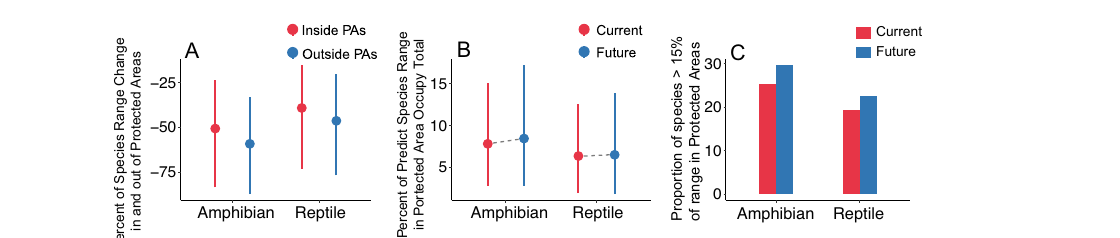
Fig. 2 | Climate change impacts on the percentage of species range (area of habitat) inside and outside PAs by 2070 (RCP 4.5). A Percent of species range change inside and outside PAs ( n =5399 and 8932 for amphibians and reptiles, respectively); B Percent of predicted species range in PAs at present and by 2070 ( n =5399 and 4876 for amphibian, 8932 and 8190 for reptile under current and amphibianspeciesand545to1098reptilespecieswillgoextinctunder